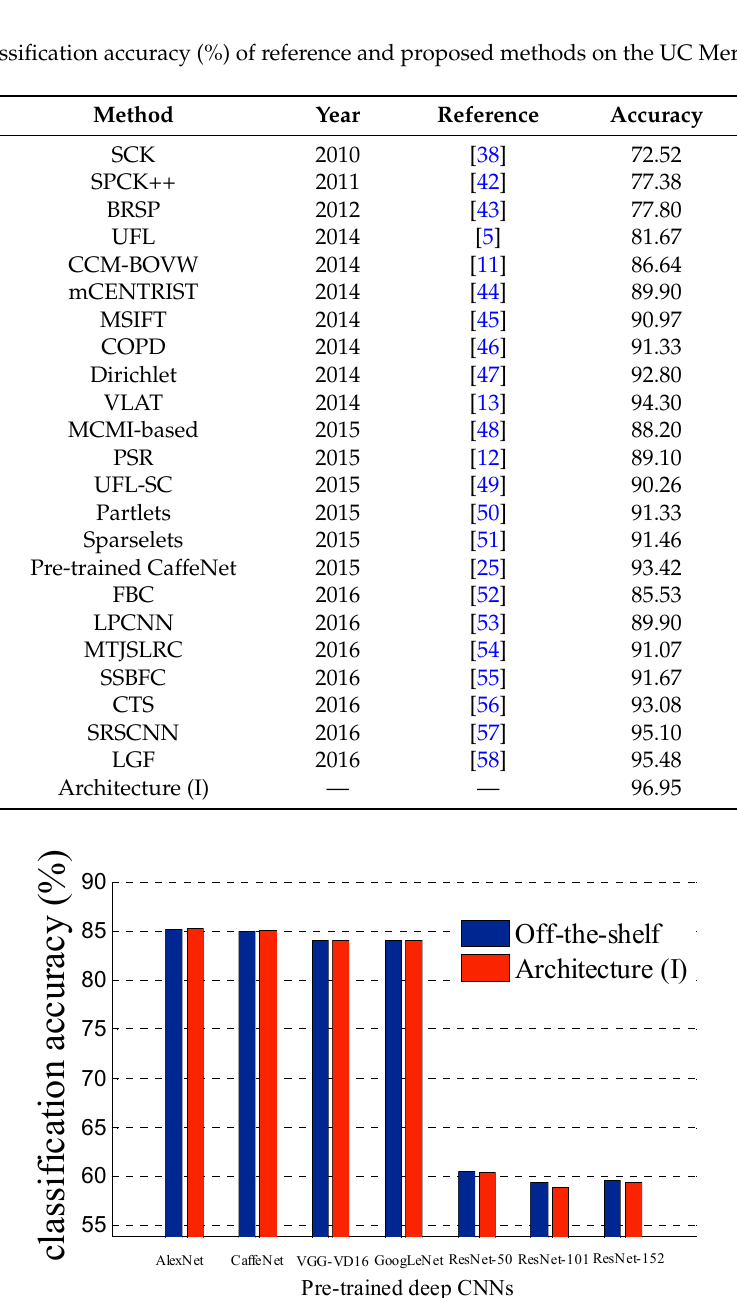
Table 4. Classification accuracy (%) of reference and proposed methods on the UC Merced dataset.